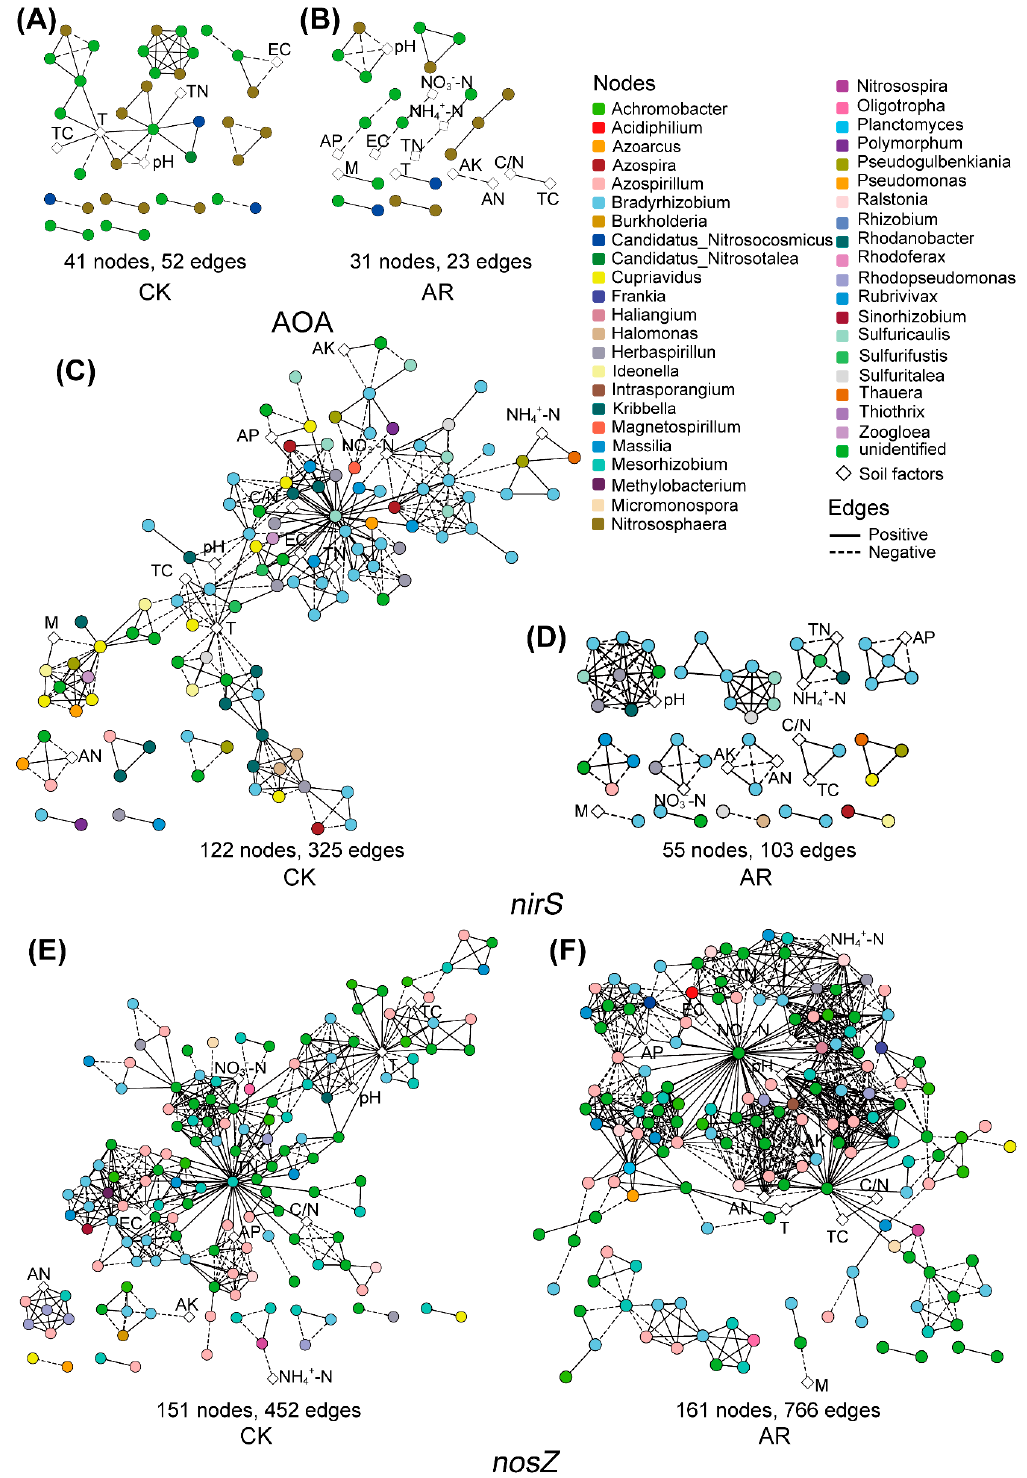
Figure 2. Co-occurrence networks of microbial communities and soil chemical factors in CK and AR treatments. AP: available P; AK: available P; AN: alkaline N; NH 4 + -N: ammonium-N; NO 3 − -N: nitrate-N; TC: total C; TN: total N; C/N: the ratio of total C to total N; M: soil moisture; EC: soil electrical conductivity; T: soil temperature. Nodes represent OTUs and soil factors with different shapes, and OTUs are colored by genus-level taxonomy. Edges indicate the significant ( p < 0.05) relationships among different OTUs. AOA: ammonia-oxidizing archaea ( A , B ); nirS and nosZ : denitrifiers carrying nirS and nosZ genes, respectively ( C – F ). CK: non-acid addition, AR: pH 4.0 acid